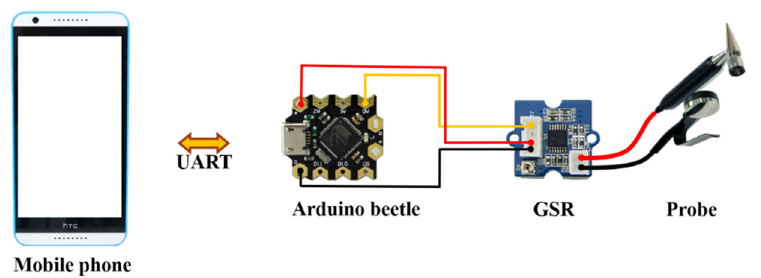
Figure 2. Wiring diagram of the GSR ( galvanic skin response) sensor.